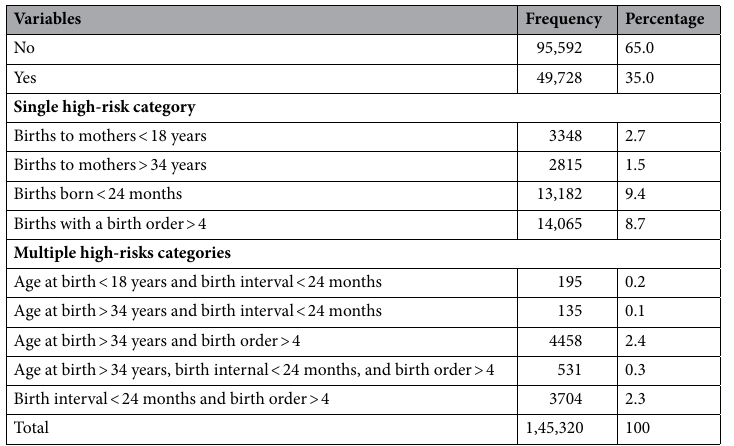
Table 1. Sample size with background characteristics of children aged 0–59 years, India